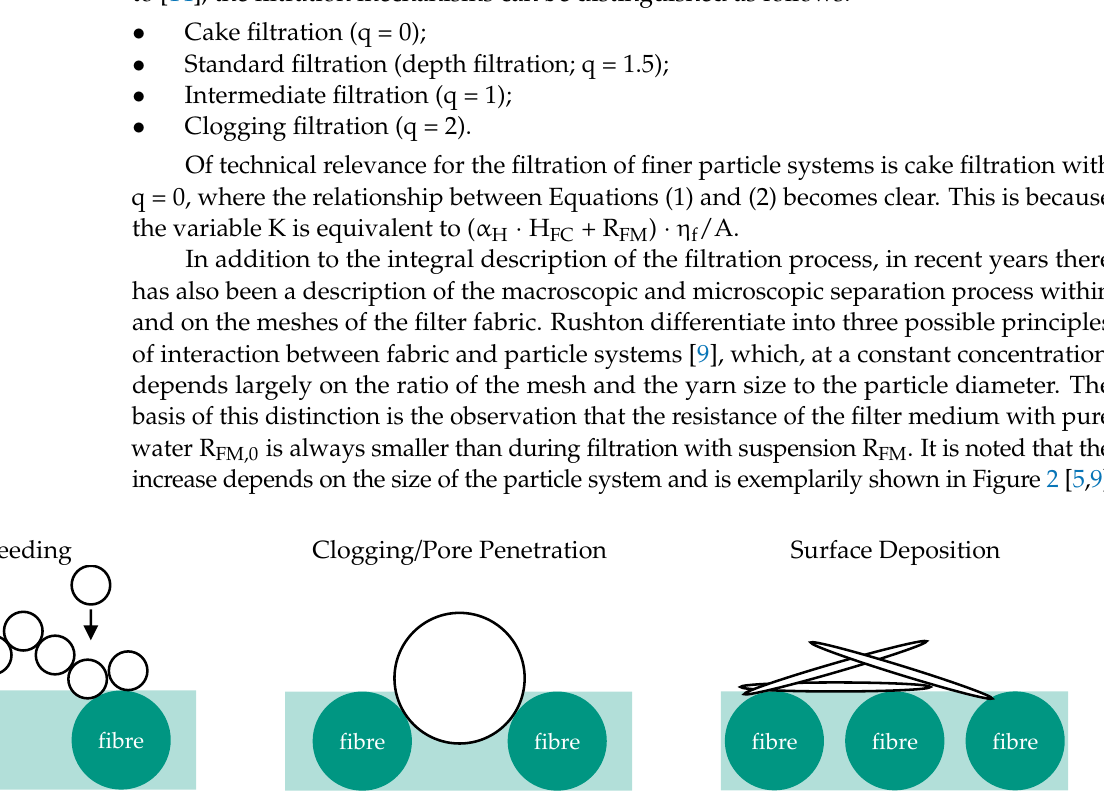
Figure 2. Schematic representation of the separation mechanisms within a fabric mesh/pore as a function of particle size and shape according to [9].